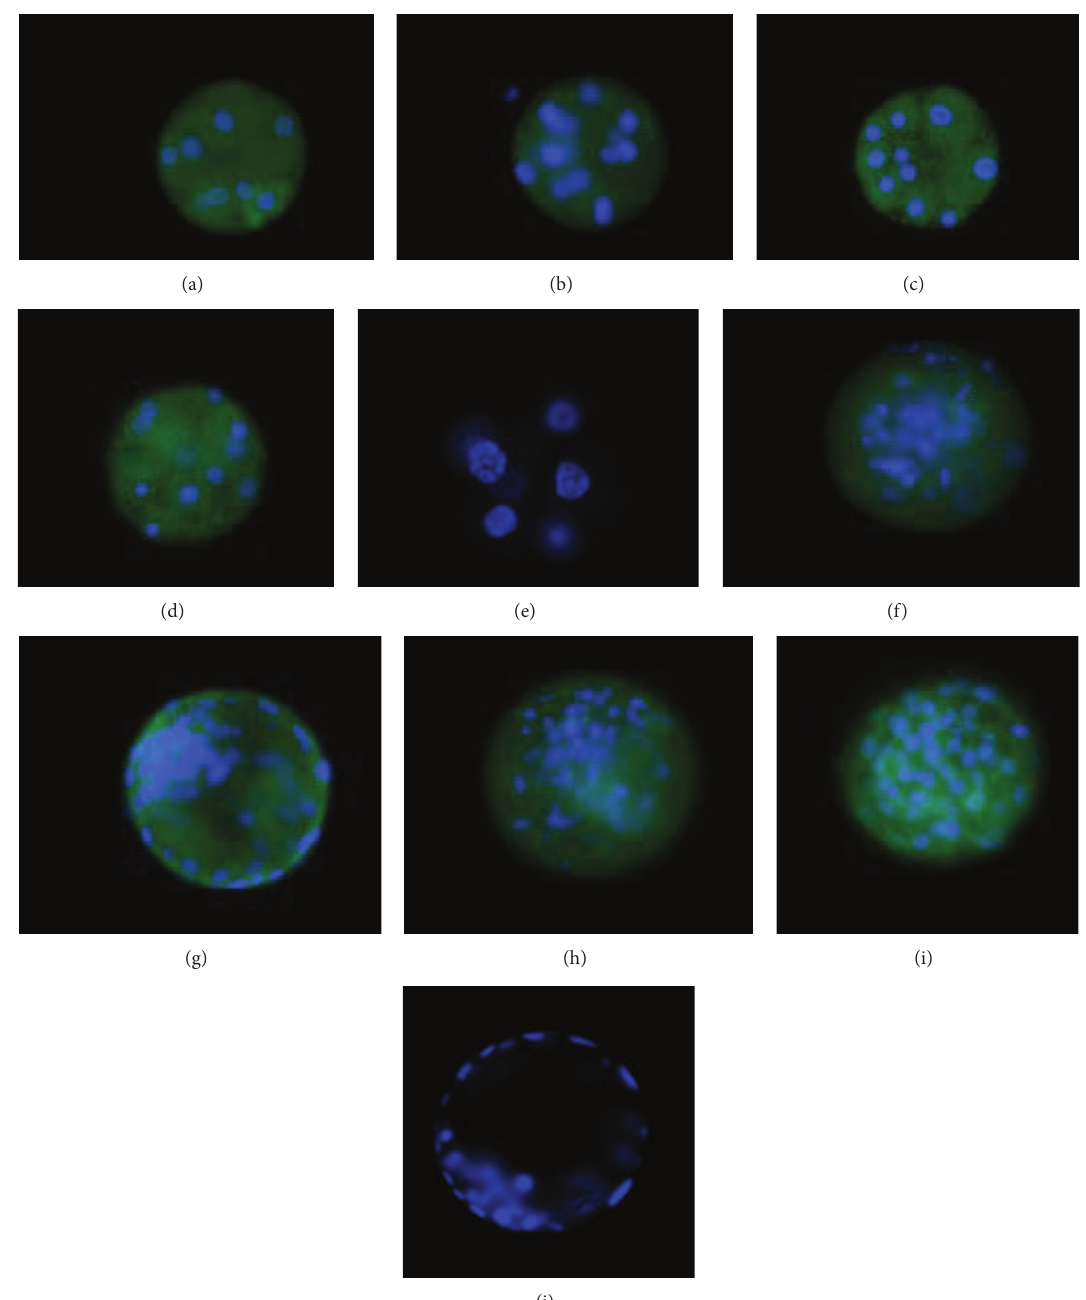
Figure 5: Expression of LPARs (LPAR1, LPAR2, LPAR3, and LPAR4) in late cleavage (Day 5; (a), (b), (c), and (d), resp.) and blastocyst (Day 8; (f), (g), (h), and (i), resp.) stage bovine in vitro produced embryos. (e) and (j) negative controls; 200x